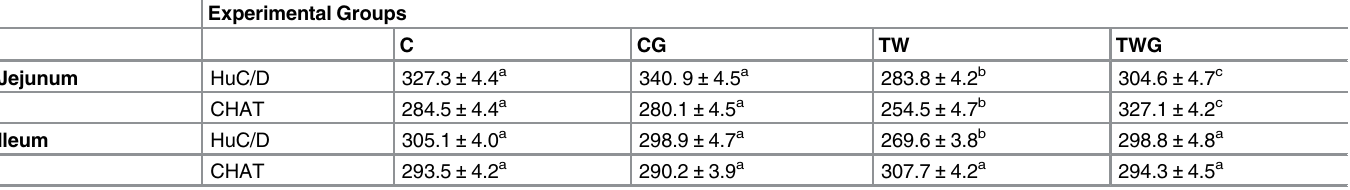
Table 6. Neuronal morphometric analysis of myenteric plexus. Neuronal cell body area ( μ m 2 ) of Jejunum and ileum from groups: control (C); control supplemented with 2% L-glutamine (CG); Walker-256 tumor (TW); and Walker-256 tumor supplemented with 2% L-glutamine (TWG). Experimental Groups